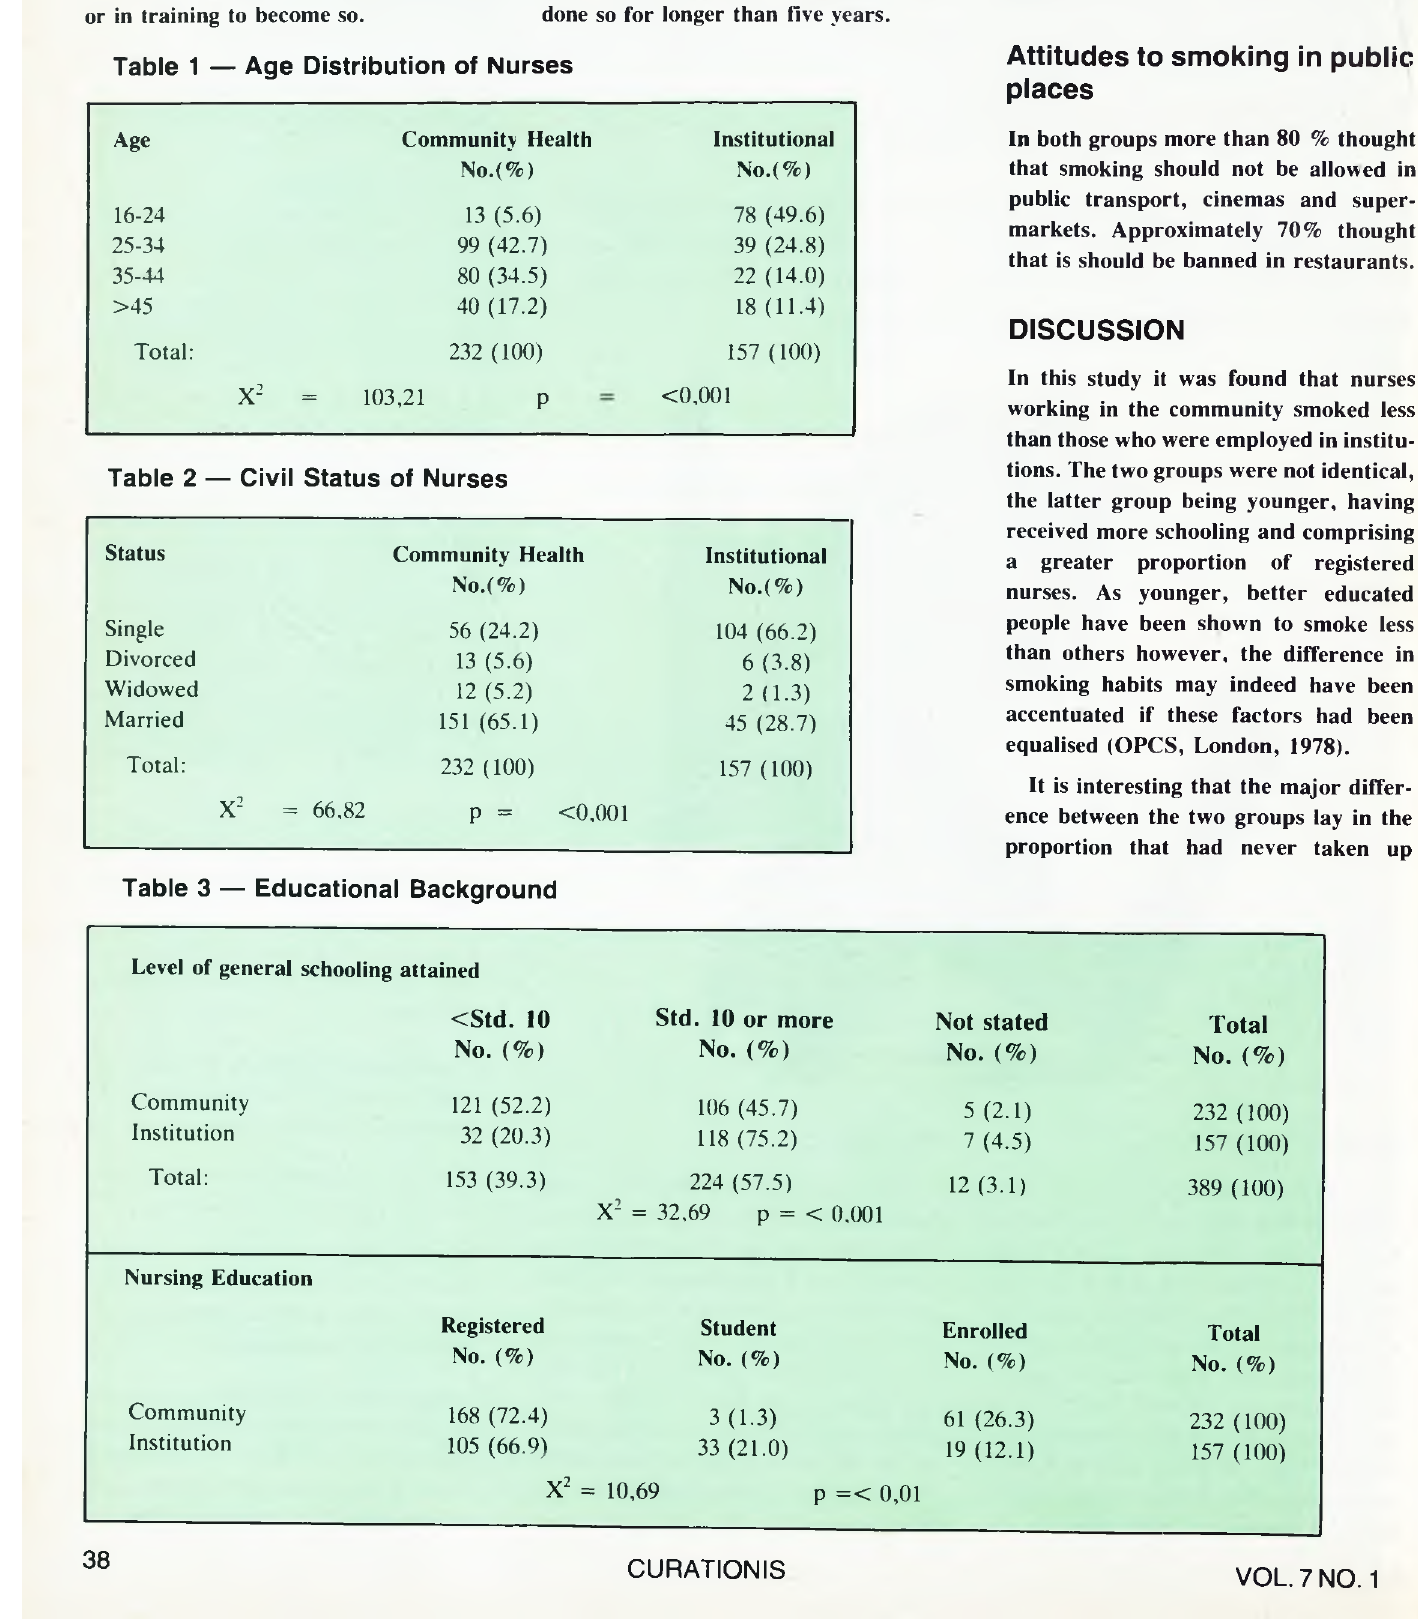
Table 1 — Age Distribution of Nurses